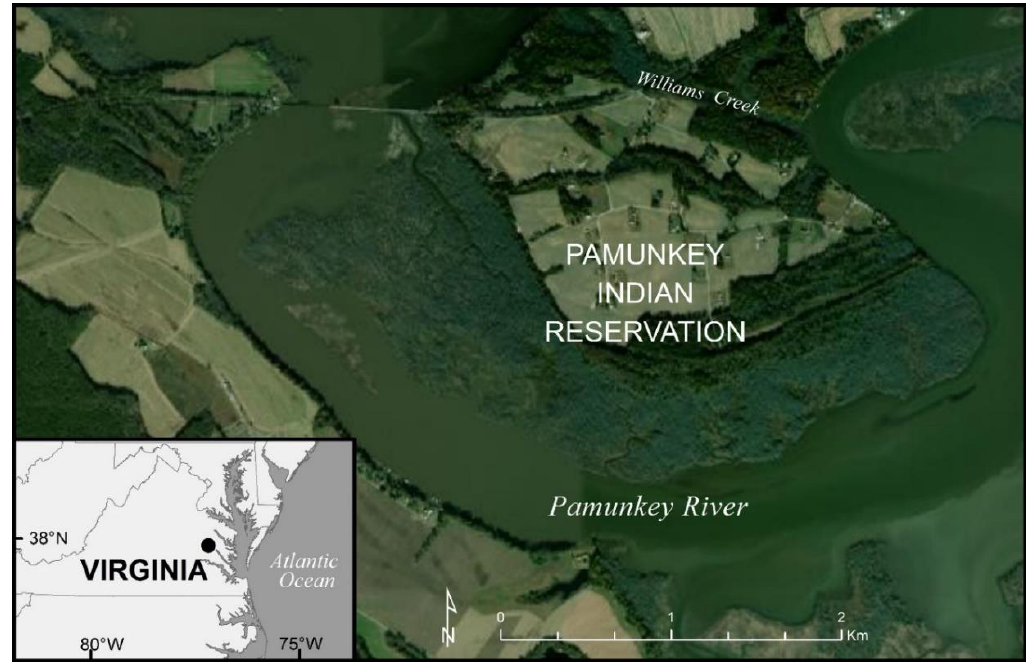
Figure 1. Study Area.